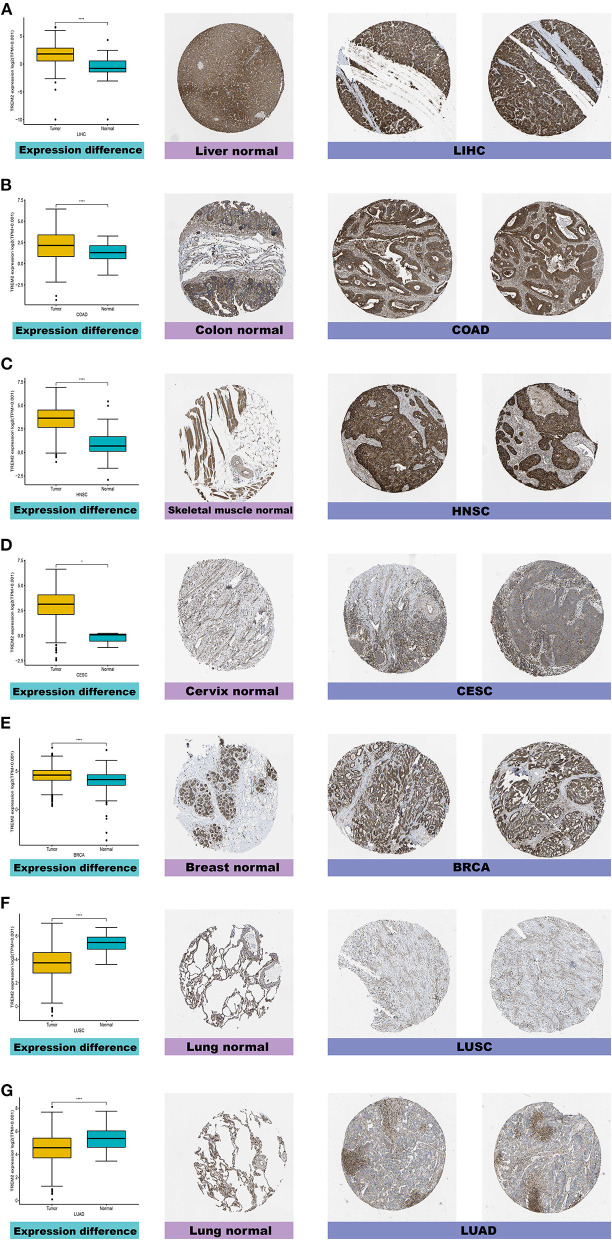
Comparison of TREM2 gene expression between normal and tumor tissues (left) and immunohistochemistry images in normal (middle) and tumor (right) tissues. TREM2 protein expression was significantly higher in liver hepatocellular carcinoma (LIHC), colon adenocarcinoma (COAD), head and neck squamous cell carcinoma (HNSC), cervical squamous cell carcinoma and endocervical adenocarcinoma (CESC), and breast invasive carcinoma (BRCA) tissues than normal tissues. (A) Liver. (B) Colon. (C) Skeletal muscle. (D) Cervix. (E) Breast. (F,G) Lung. ****P < 0.0001.